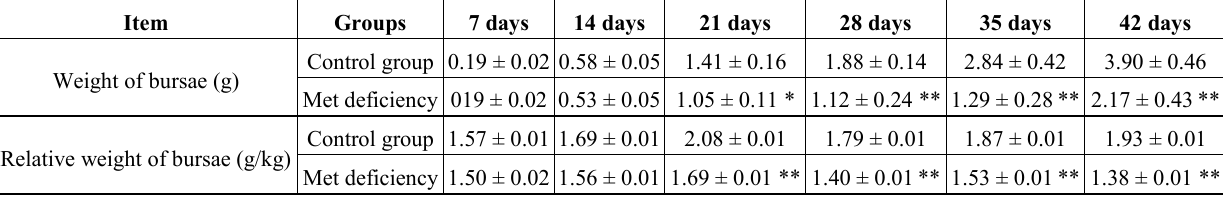
Table 2. Effect of Met deficiency on weight and relative weight of the bursa of